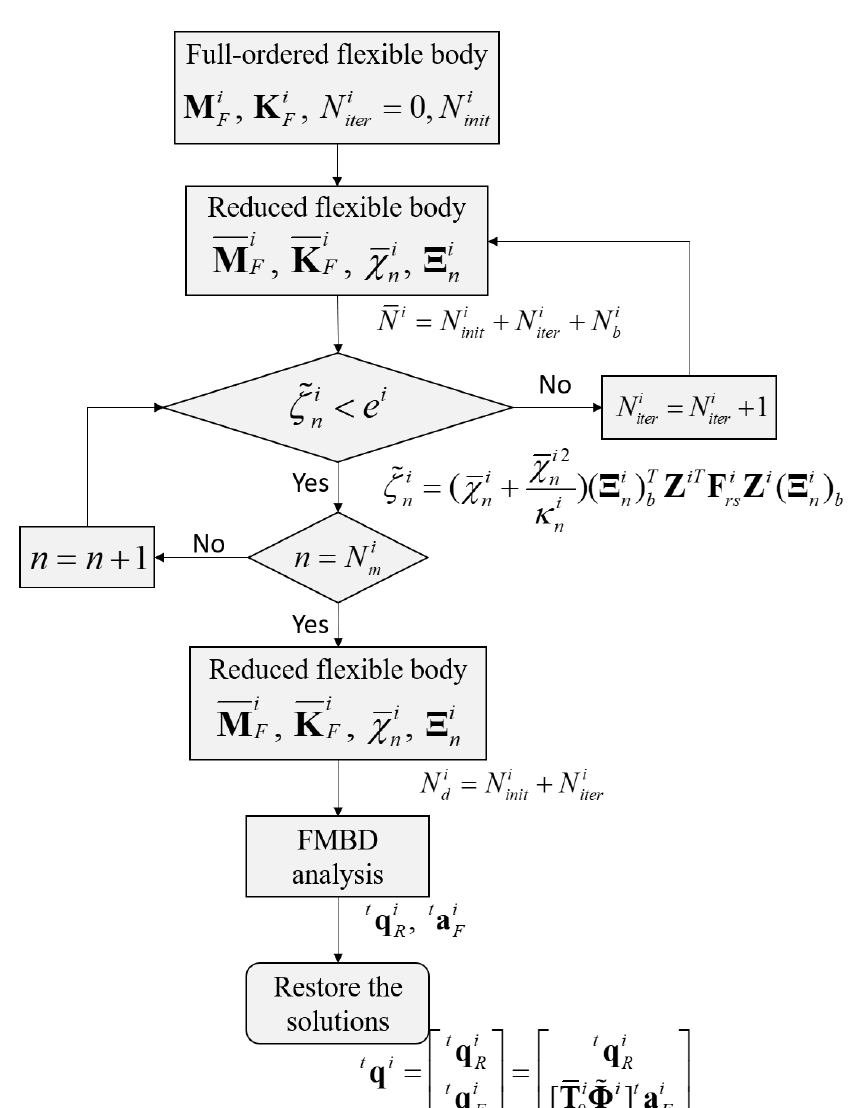
Figure 1. Iterative process using the error estimator. In the process of generating the reduced model, the dominant mode addition operation is repeated to satisfy that all of the relative eigenvalue errors within the specified mode range N i m are less than e i . FMBD, flexible multibody